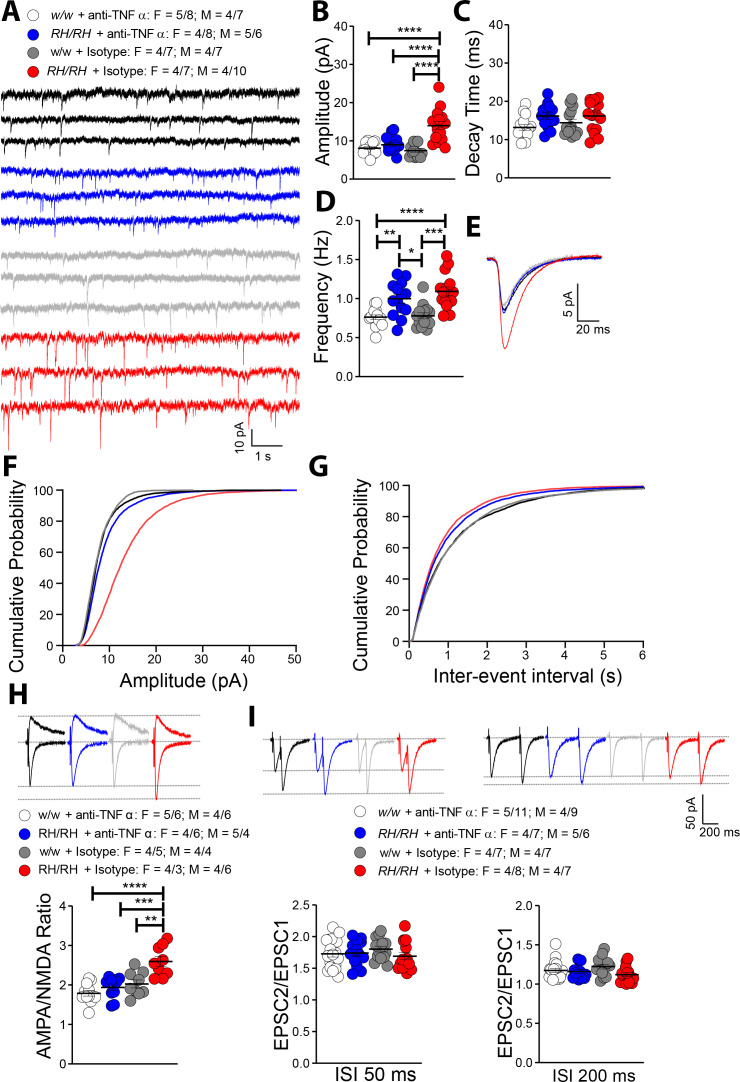
Rapid reduction of excess TNF-α activity normalizes amplitude of glutamatergic synaptic responses in young Trem2R47H/R47H rats.(A) Representative mEPSC traces. (B) The increase in mEPSC amplitude caused by the Trem2R47H variant is occluded by anti-TNF-α application but not by the IgG isotype control [F(3, 54)=18.79, p<0.0001****; post-hoc Tukey's multiple comparisons test: w/w + anti-TNF-α vs. RH/RH + anti-TNF-α, p=0.7884 (ns); w/w + anti-TNF-α vs. RH/RH + Isotype, p<0.0001****; w/w + anti-TNF-α vs. w/w + Isotype, p=0.9252 (ns); RH/RH + anti-TNF-α vs. RH/RH + Isotype, p<0.0001****; RH/RH + anti-TNF-α vs. w/w + Isotype p=0.4299 (ns); RH/RH + Isotype vs. w/w + Isotype, p<0.0001****]. (C) Decay time of mEPSC was not changed by either genotype or treatments [F(3, 54)=2.716, p=0.0536]. (D) The increased frequency of mEPSC observed in Trem2R47H/R47H rats was not significantly affected by either anti-TNF-α or isotype control IgG [F(3, 54)=12.05, p<0.0001****; post-hoc Tukey's multiple comparisons test: w/w + anti-TNF-α vs. RH/RH + anti-TNF-α, p=0.0046**; w/w + anti-TNF-α vs. RH/RH + Isotype, p<0.0001****; w/w + anti-TNF-α vs. w/w + Isotype, p=0.9947 (ns); RH/RH + anti-TNF-α vs. RH/RH + Isotype, p=0.5147 (ns); RH/RH + anti-TNF-α vs. w/w + Isotype p=0.0109*; RH/RH + Isotype vs. w/w + Isotype, p<0.0001****]. (E) Average mEPSC of the four groups. Cumulative probability of AMPAR-mediated mEPSC amplitudes (F) and inter event intervals (G). (H) The increase of AMPA/NMDA ratio observed in Trem2R47H/R47H rats was reversed by anti-TNF-α but not IgG isotype control [F(3, 36)=13.50, p<0.0001****; post-hoc Tukey's multiple comparisons test: w/w + anti-TNF-α vs. RH/RH + anti-TNF-α, p=0.6507 (ns); w/w + anti-TNF-α vs. RH/RH + Isotype, p<0.0001****; w/w + anti-TNF-α vs. w/w + Isotype, p=0.2880 (ns); RH/RH + anti-TNF-α vs. RH/RH + Isotype, p=0.0002***; RH/RH + anti-TNF-α vs. w/w + Isotype p=0.9171 (ns); RH/RH + Isotype vs. w/w + Isotype, p<0.0015**]. Representative traces are shown above the graph (traces are averaged from 20 sweeps). (I) Neither genotype nor treatment changed average PPF at 50 ms (left panel) and 200 ms (right panel) ISI [PPF at 50 ms ISI: F(3, 58)=0.7420, p=0.5313; PPF at 200 ms ISI: F(3, 58)=2.356, p=0.0812]. Representative traces are shown above the panels. Data are represented as mean ± SEM and were analyzed by ordinary one‐way ANOVA followed by post-hoc Tukey's multiple comparisons test when ANOVA showed significant differences. Number of animals and of recordings are shown as explained in Figure 5.Figure 6—source data 1.Related to Figure 6B,C,D,H,I.